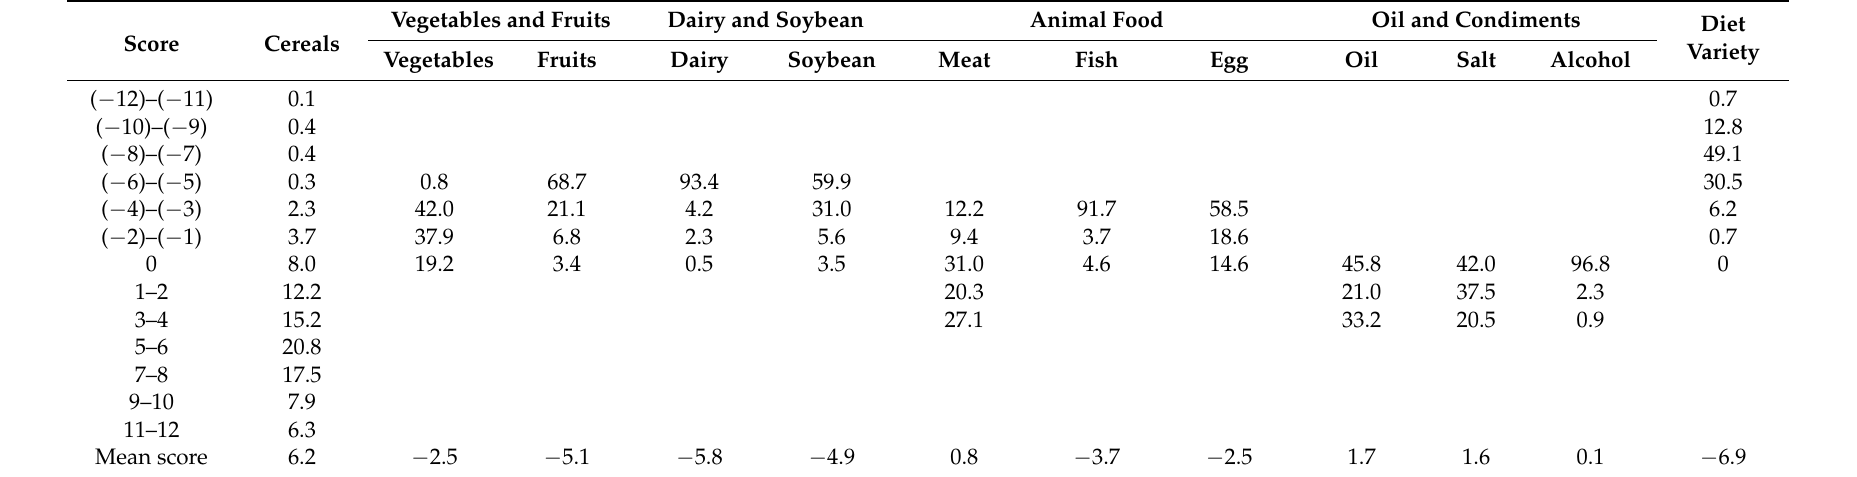
Table 3. Scores for the DBI-07 components and the percentage of the participants with each